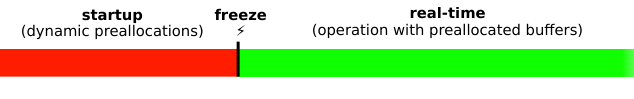
Figure 14. Real time application